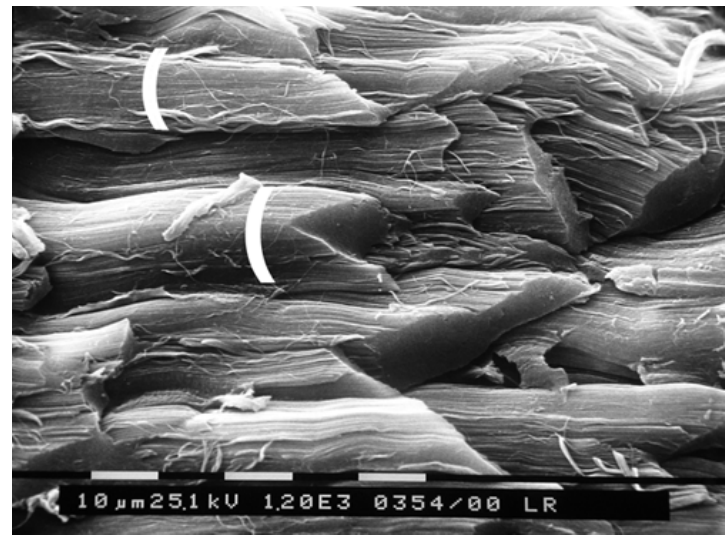
FIGURE 7 . SEM image of rat Achilles tendon subfascicles (parentheses). Bar = 10 μ